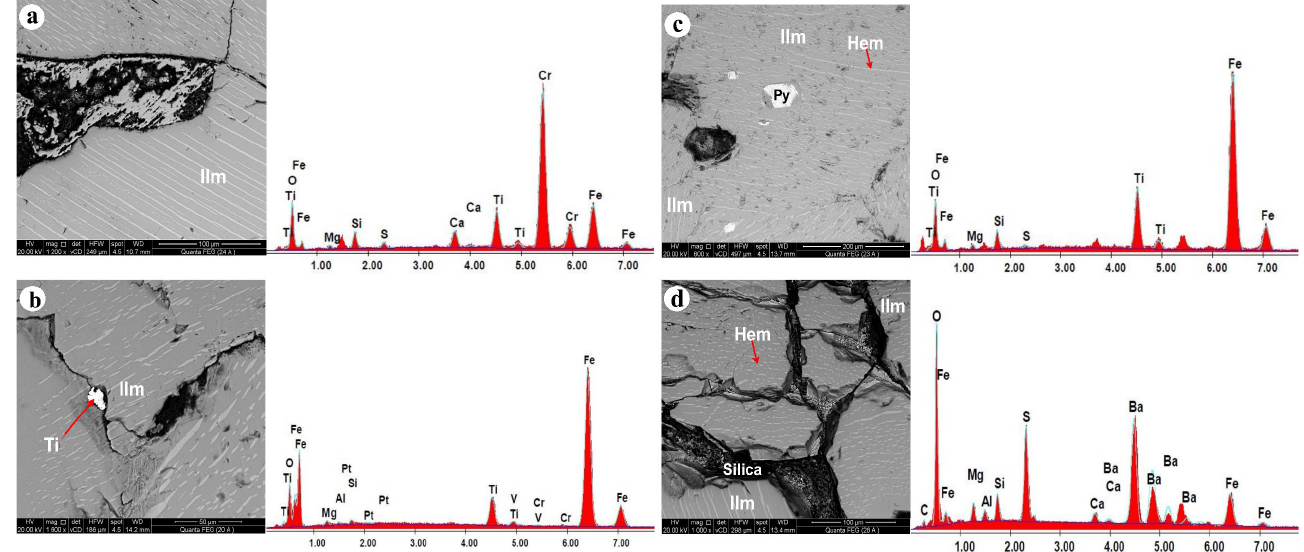
Figure 7. Back-scattered electron (BSE) images and EDX spot analyses of the studied Fe-Ti oxides. ( a ) Exsolution of intergrowth of ilmenite sandwich. ( b ) Lens-shaped exsolution of hematite in planes of the host ilmenite. ( c ) Ilmenite with very fine hematite exsolution lamellae associated with pyrite crystal (Py). ( d ) Hemo-ilmenite demonstrated by a progressive increase in size and number of hematite lenses and silicate content along fracture.